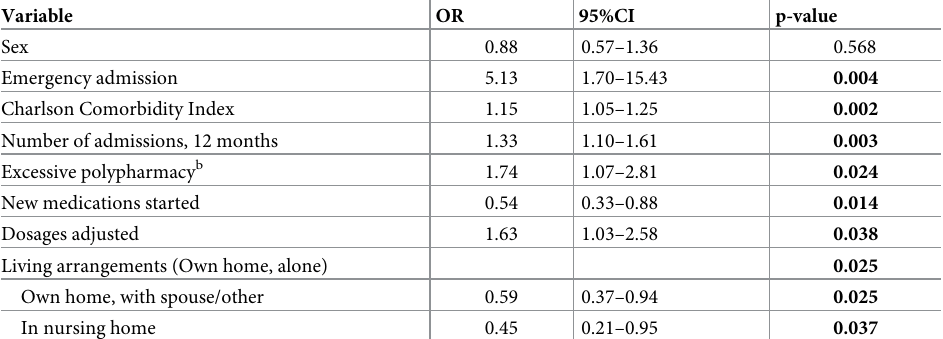
Table 4. Variables associated with possibly medication-related readmission to hospital within 30 days of discharge a .